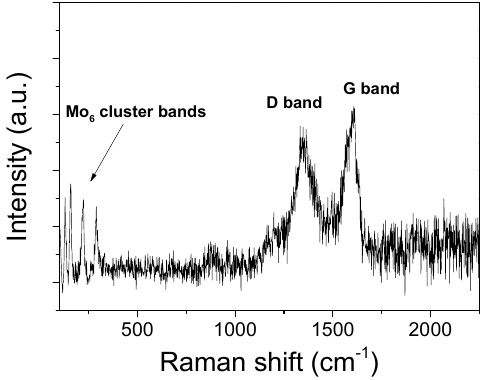
Figure 5. Raman spectrum of (TBA) 2 Mo 6 I i 8 @GO under 514 nm excitation.